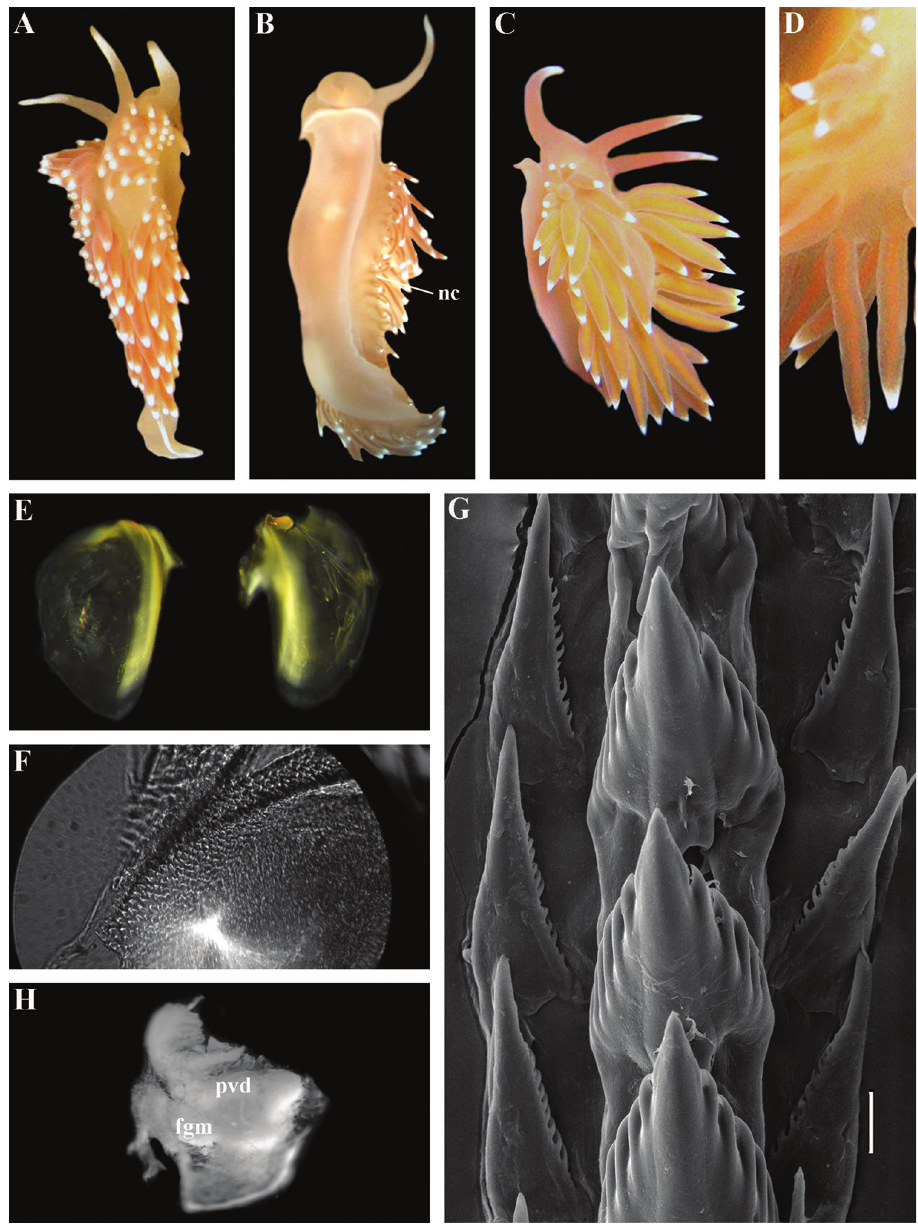
Figure 29. Itaxia falklandica (Eliot, 1907), comb. n. South Pacific, Chile, Canal Artilleria, ZSM Mol- 20070592, specimen 12 mm length (fixed): A dorsal view (live) B ventral view (live) C lateral view (live) D details of cerata (live) E jaws, light microscopy F details of masticatory process of jaw, light microscopy G radular teeth, posterior part, SEM H reproductive system (non mature), light microscopy. Abbreviations: fgm female gland mass nc continuous notal edge pvd prostatic vas deferens. Scale bars: G = 30 μm. Photos of living specimens by M. Schrödl, other photos and SEM images by A.V.